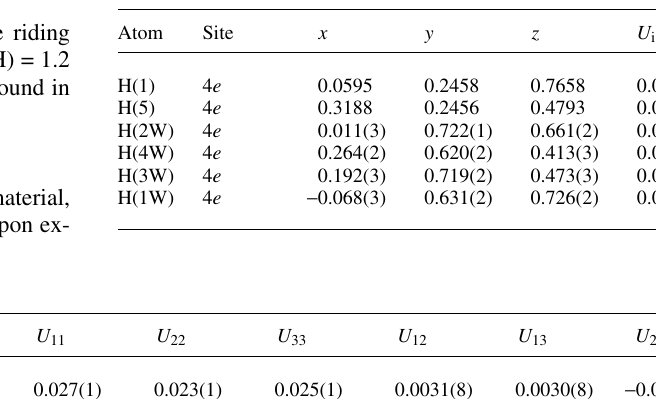
Table 2. Atomic coordinates and displacement parameters (in Å 2 ) .